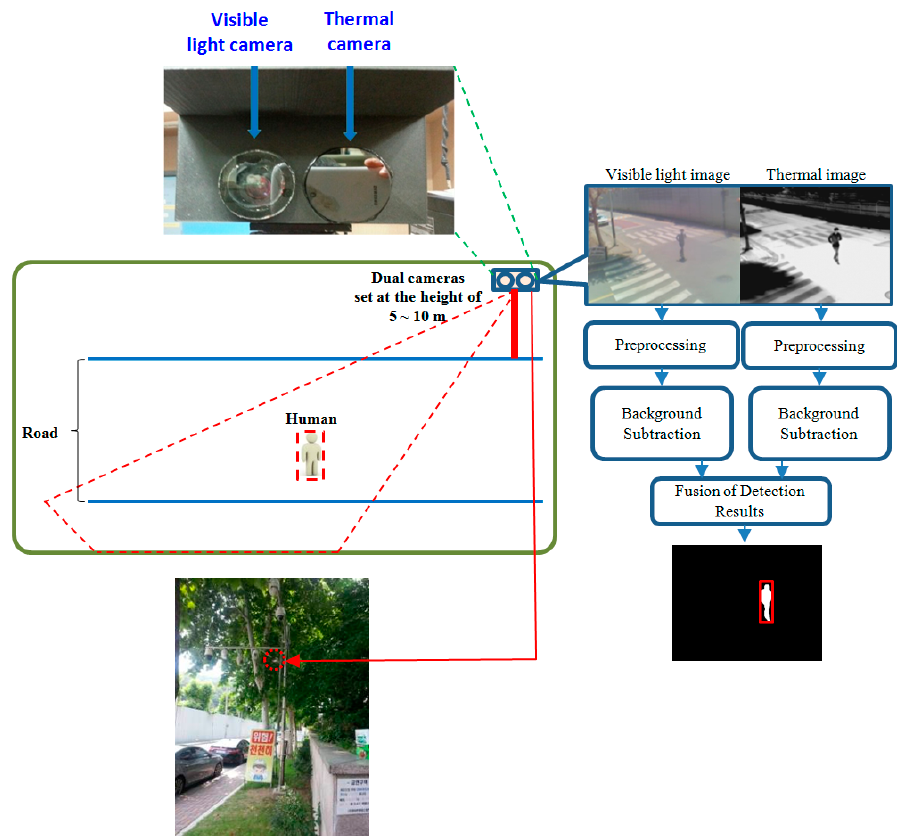
Figure 1. Examples of system setup with brief explanations of our human detection method.